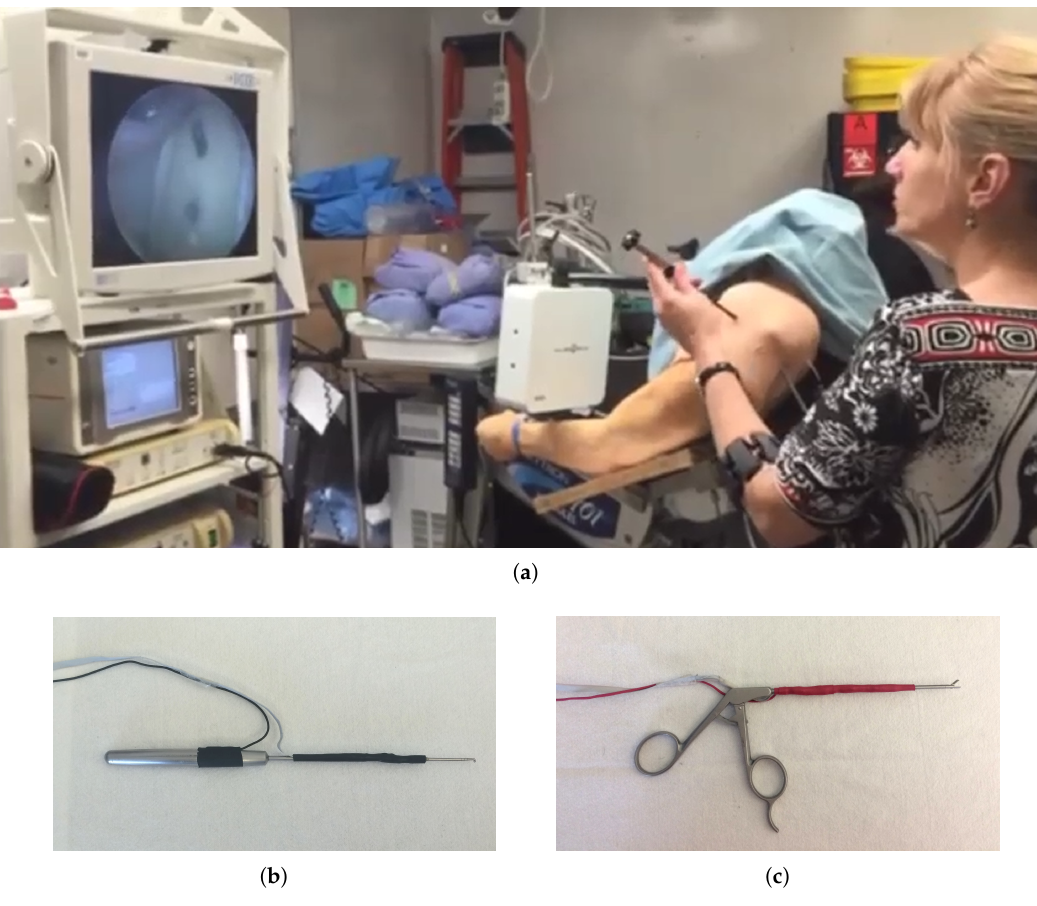
Figure 1. Shoulder simulator and video tower ( a ), the sensorized arthroscopic probe ( b ), and the sensorized arthroscopic grasper ( c